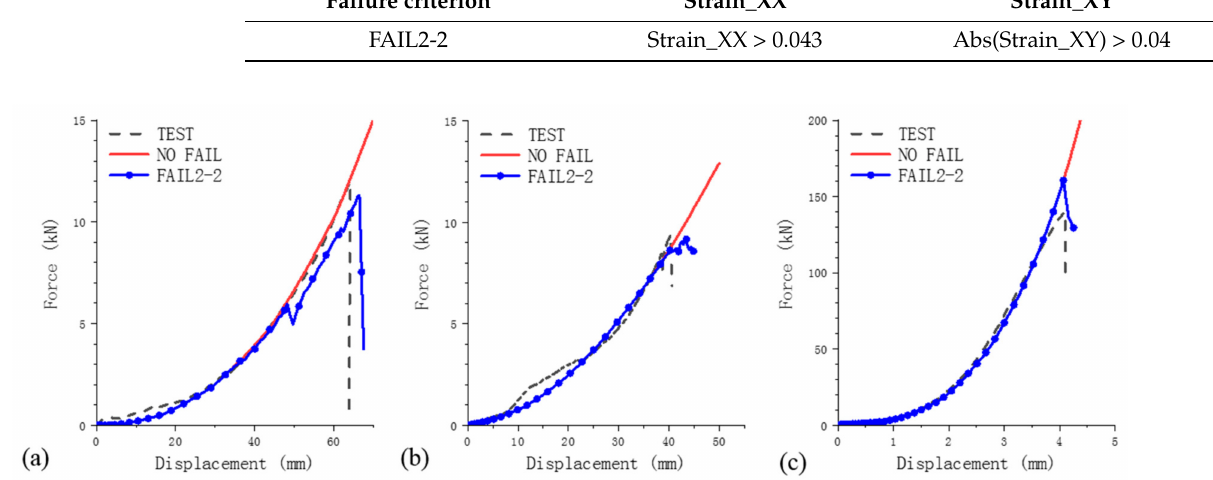
Figure 13. Simulation results with failure criterion considering tension strain and shear strain: ( a ) X direction; ( b ) Y direction; ( c ) Z